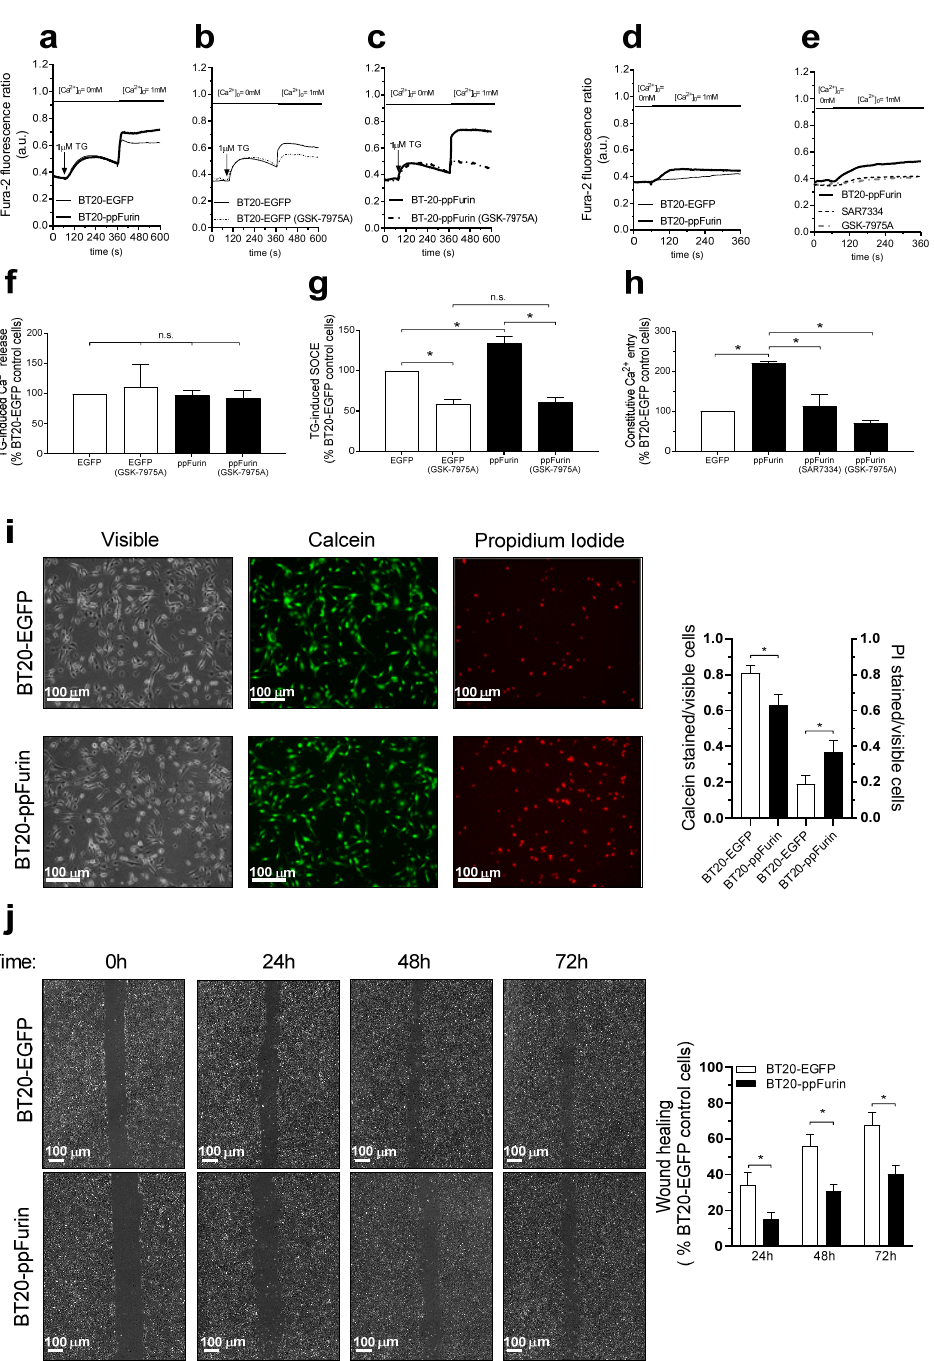
Figure 8. Effect of ppFurin expression on Ca 2+ entry, cell migration, and viability in triple negative BT20 breast cancer cells. ( a – h ) Control BT20 and BT20 cells expressing ppFurin were loaded with Fura-2 and perfused with a Ca 2+ -free medium (100 µM of EGTA added). Cells were pretreated for 1 min with 10 µM of GSK-7975A or the vehicle ( b , c , e ) or for 10 min with 1 µM of SAR7334 ( e ). Cells were then stimulated with TG (1 µM) followed by reintroduction of external Ca 2+ (final concentration 1 mM) to initiate Ca 2+ entry ( a – c ), or were subjected to Ca 2+ re-addition to determine the existence of constitutive Ca 2+ entry ( d , e ). Traces are representative of 40 cells/day/3–5 days. ( f – h ) Bar graphs represent TG-induced Ca 2+ release ( f ), SOCE ( g ), and constitutive Ca 2+ entry ( h ), as indicated, as the area under the curve, expressed as mean ± SEM, and presented as percentage of control (BT20-EGFP control cells). Statistical significance was assessed by Student’s t -test and * represents p < 0.05 as compared to their respective controls. ( i ) Control BT20 and BT20 cells expressing ppFurin cells were loaded with calcein and propidium iodide (PI). Cell staining was visualized using an inverted microscope as described in the Material and Methods. Bar graphs represent the calcein and propidium iodide staining under the different